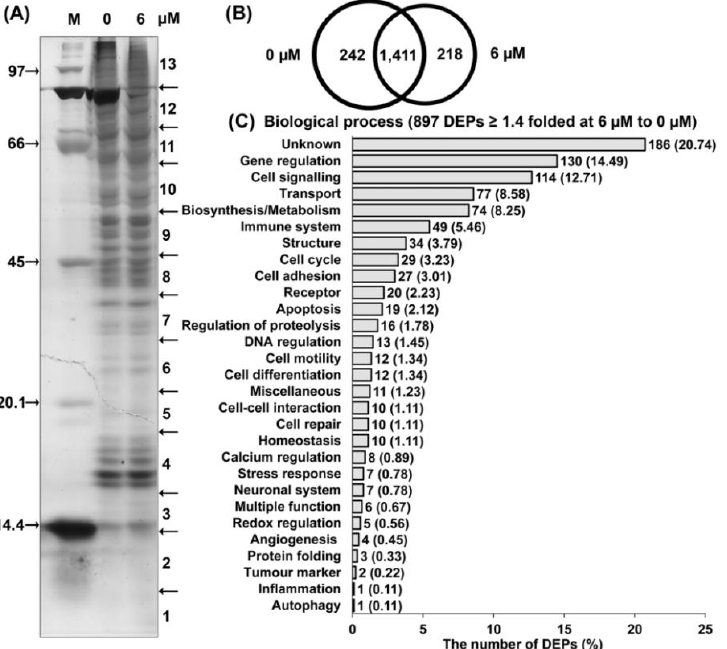
Figure 3. Proteomic analysis of 7- α -hydroxyfrullanolide (7HF)-treated triple-negative breast cancer cells. ( A ) Proteins (10 µ g) were separated by 12.5% sodium dodecyl sulfate-polyacrylamide gel electrophoresis and the gel was excised into 13 horizontal slices (1–13). M = Protein marker. ( B ) Venn diagram representing the total number of proteins expressed under individual and shared treatment conditions. ( C ) The significance of the number of differentially expressed proteins (DEPs) under treatment with 6 µM 7HF (≥1.4 -fold compared to values in the control) and the biological process classifications.